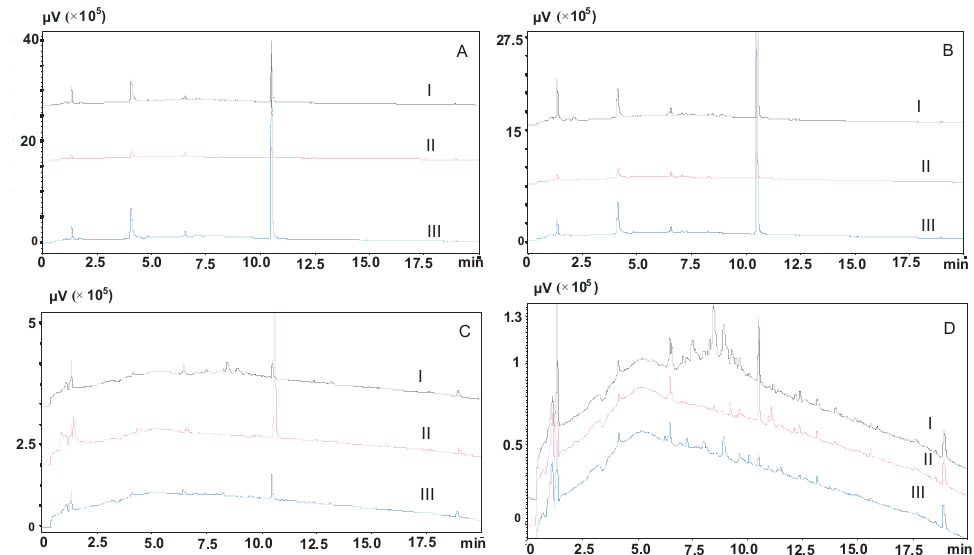
Figure 1. Chromatograms of blank saliva samples after elution of column with methanol. ( A )—procedure 1, ( B )—procedure 2, ( C )—procedure 3, ( D )—procedure 4; I—Strata X columns, II—Strata X-C columns, III—Strata X-CW columns.